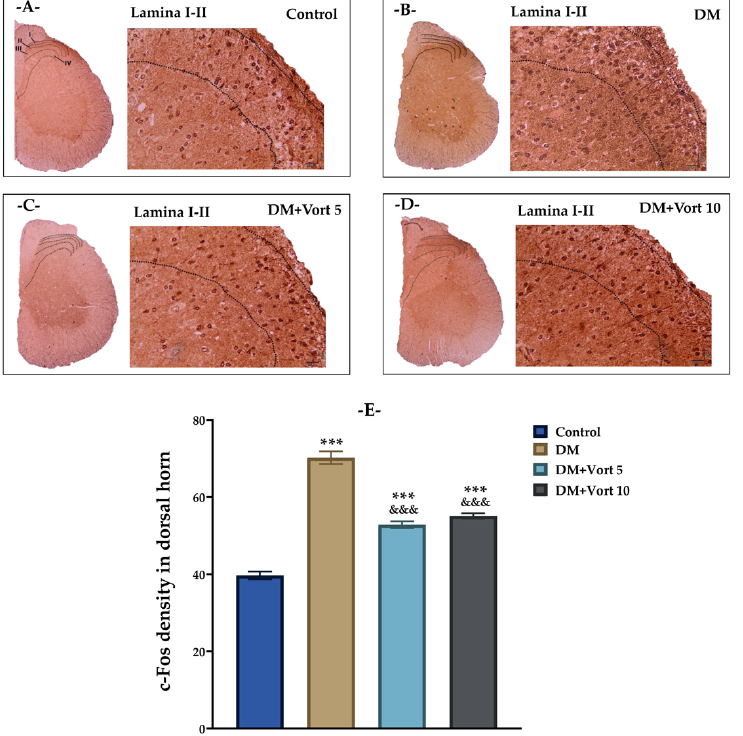
Figure 11. Representative images of c-Fos-immunoreactivities in the superficial layer (laminae I and II) of the lumbar spinal cord (L4–L5 segment) dorsal horn of control ( A ), diabetic (DM) ( B ), 5 mg/kg vortioxetine-administered diabetic (DM+Vort 5) ( C ) and 10 mg/kg vortioxetine-administered diabetic (DM+Vort 10) ( D ) rats. Scale bar = 20 µ m. c-Fos densities in dorsal horn of control, diabetic